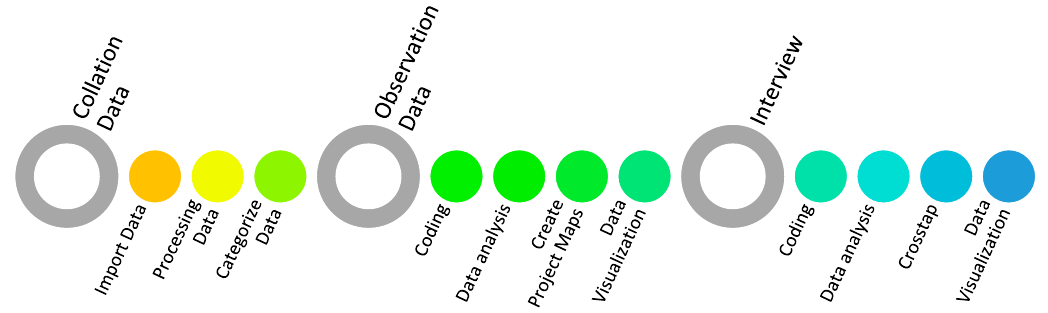
Figure 2. Data collection and analysis techniques with NVivo 12 Pro . Source: processed from Woolf and Silver (2017), 2022.